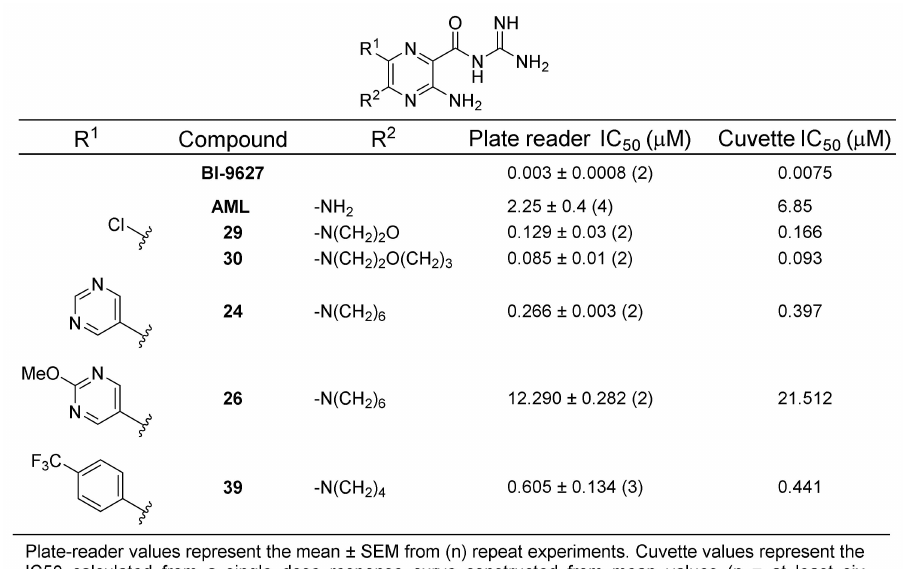
Figure 2. Comparative NHE1 inhibition data (IC 50 ) obtained using plate-reader and cuvette fluorescence assays.